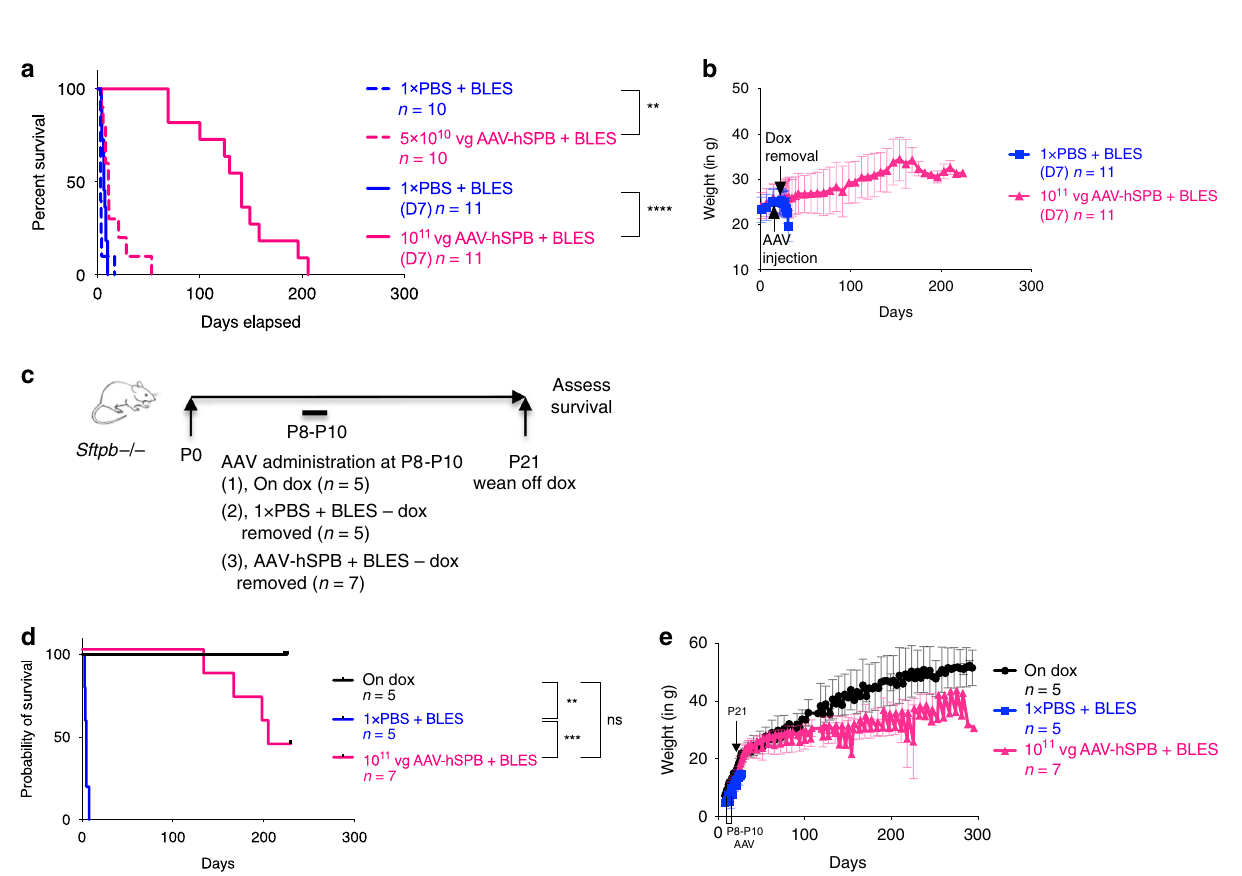
Fig. 8 AAV-hSPB improves survival in neonatal and adult mice. a Kaplan-Meier survival curves following IT delivery of 5 × 10 10 vg per mouse (dashed pink line; ** P = 0.0019) of AAV-hSPB plus BLES with dox removal 28 days after AAV administration, and IT delivery of 10 11 vg per mouse (solid pink line; **** P < 0.0001) of AAV-hSPB plus BLES with dox removal 7 days (D7) after AAV administration. b Mean weight measurements with SD of all surviving mice either treated with 1× PBS (blue squares) or 10 11 vg of AAV-hSPB plus BLES (pink triangles) from a . c Study design to assess survival following IT delivery of 10 11 vg per mouse AAV-hSPB plus BLES gene therapy in postnatal (P)8 to P10 SP-B de fi cient mice. Mice were removed from dox upon weaning at P21. d Kaplan-Meier survival curves following IT delivery of 10 11 vg per mouse of AAV-hSPB plus BLES (pink line; *** P = 0.0004) at P8 to P10 with dox removal at P21. Control mice were untreated and maintained on dox (black line; ** P = 0.0021) or underwent sham surgeries with IT injections of 1× PBS plus BLES (blue line). e Mean weight measurements with SD of all surviving mice untreated and maintained on dox (black circles), treated with 1× PBS plus BLES with dox removed (blue squares), or treated with 10 11 vg of AAV-hSPB plus BLES with dox removed (pink triangles) from d . (Survival curve P values of a = 2-tailed Log-rank, Mantel-Cox test; Survival curve P values of d = 2-tailed Log-rank, Mantel-Cox test with Bonferroni correction, signi fi cance is set at P = 0.0167, ns = not signi fi cant) (BLES = Bovine Lipid Extract